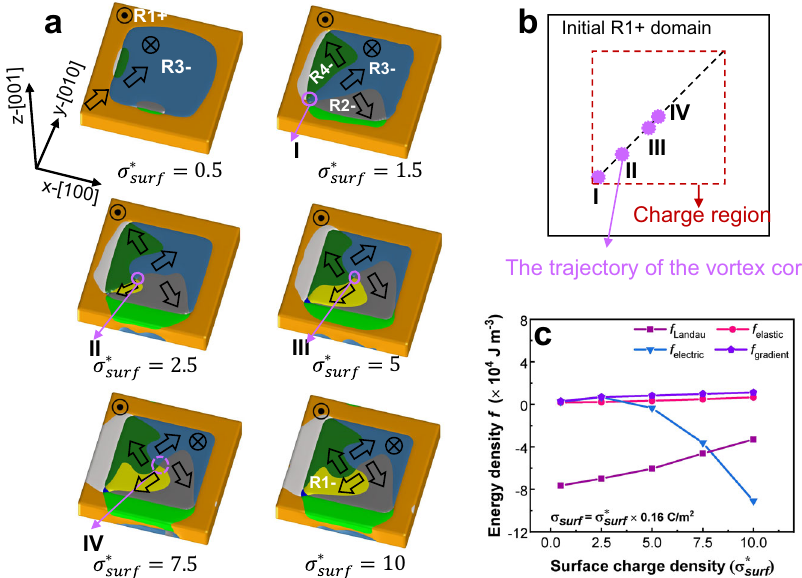
Fig. 3 The domain evolution with different positive surface charge densities ( σ surf ). a Domain evolution with different σ surf . σ (cid:3) ´ 0 : 16C = m 2 ). b The trajectory of the vortex core movement. c The energy density distribution vs positive surface normalized value ( σ surf ¼ σ (cid:3) surf charge density.